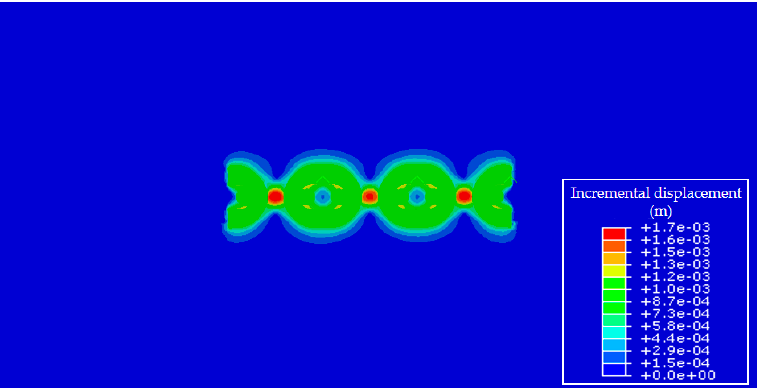
Figure 5. Relationship between the normalized normal resistance and normal displacement. Com- pared with [10,17,19,20].